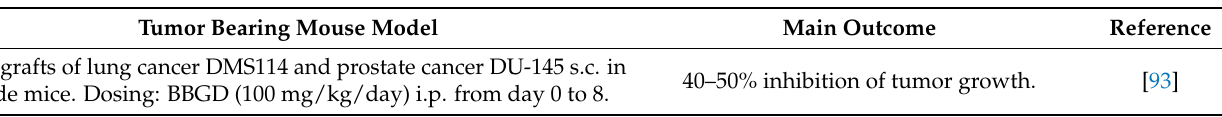
Table 3. Anti-cancer activity of cell permeable Glo1 inhibitor, S-p-bromobenzylglutathione cy- clopentyl diester, in tumor-bearing mice in